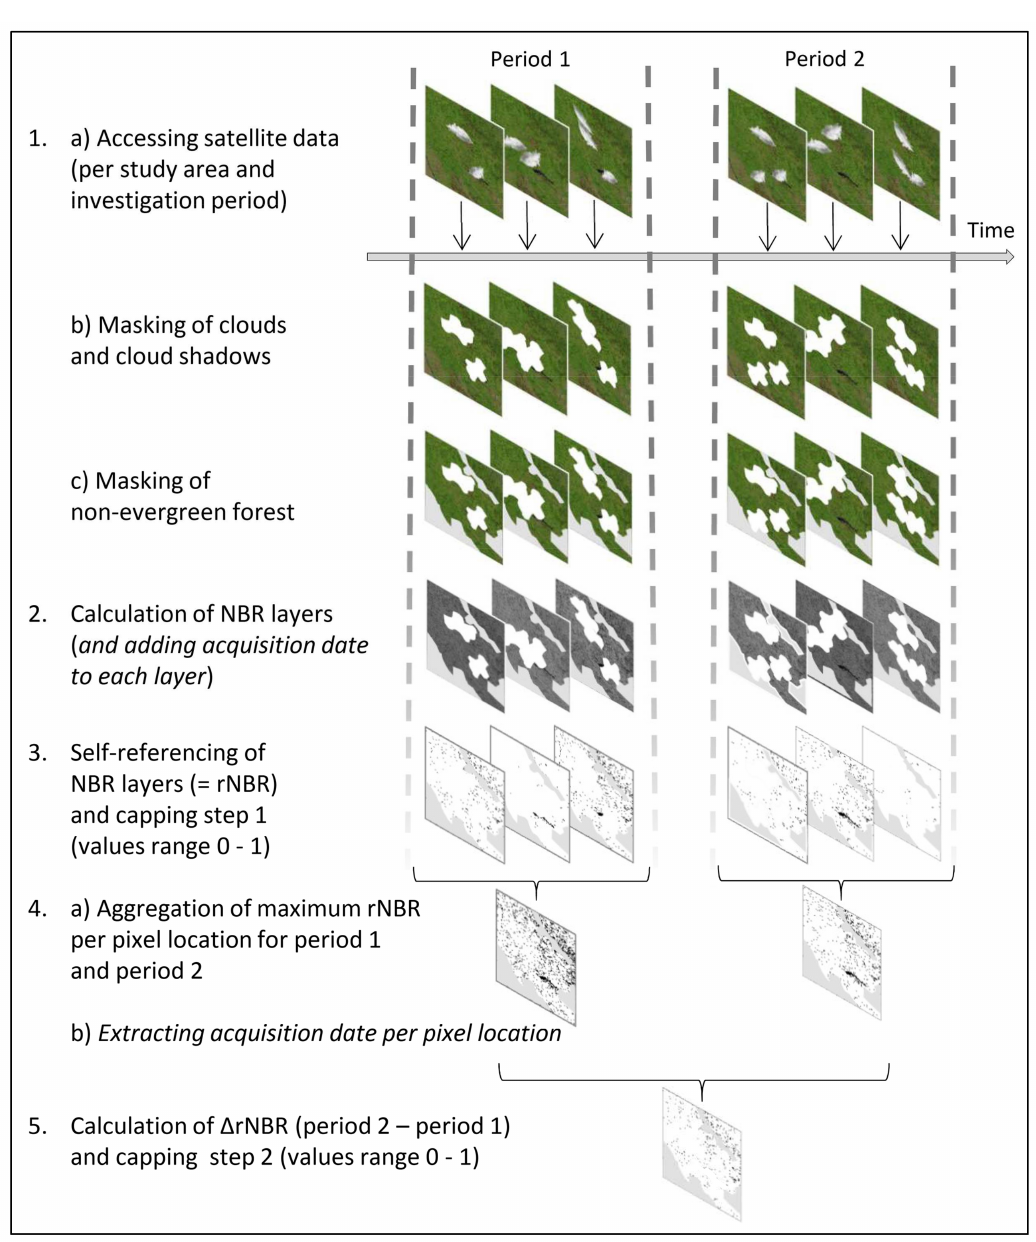
Figure 2. Flow chart and visualization of the major five processing steps to derive canopy cover disturbance ( ∆ rNBR) maps based on change detection analysis from two